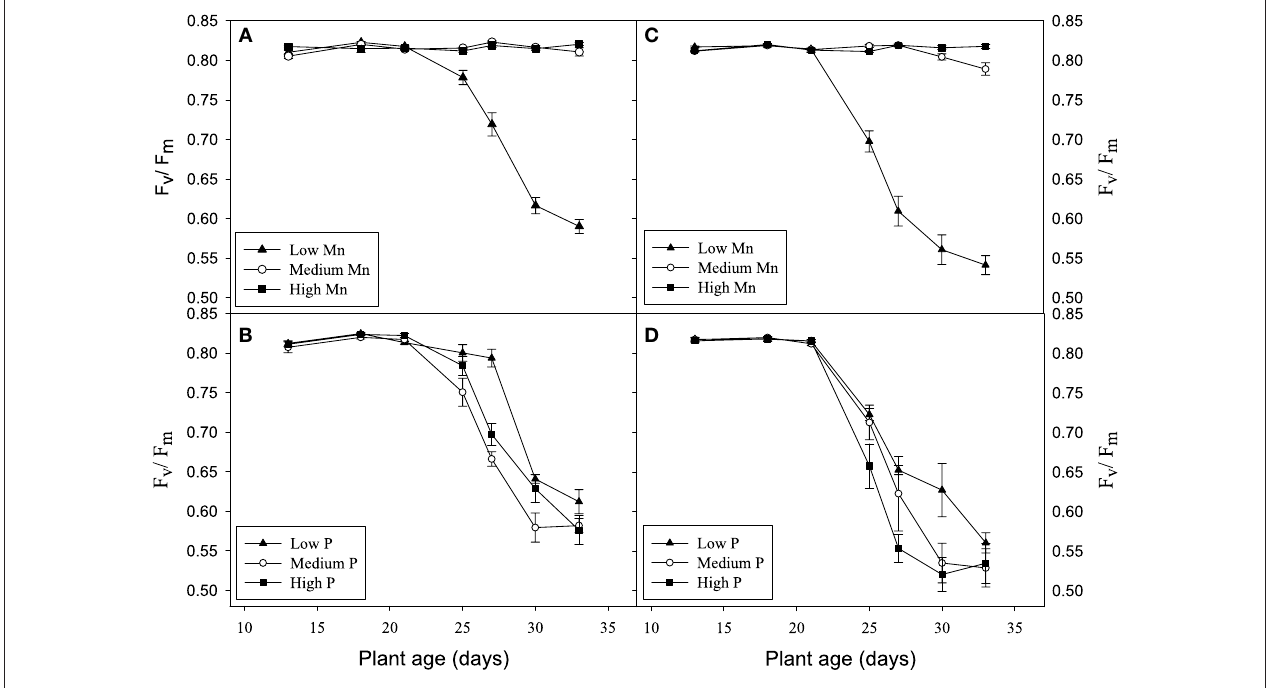
FIgure 5 | Chlorophyll a fluorescence measurements of hydroponically grown plants receiving different Mn and P levels. F Mn-inefficient genotype Antonia (A,B) and the efficient genotype Vanessa (C,D) .